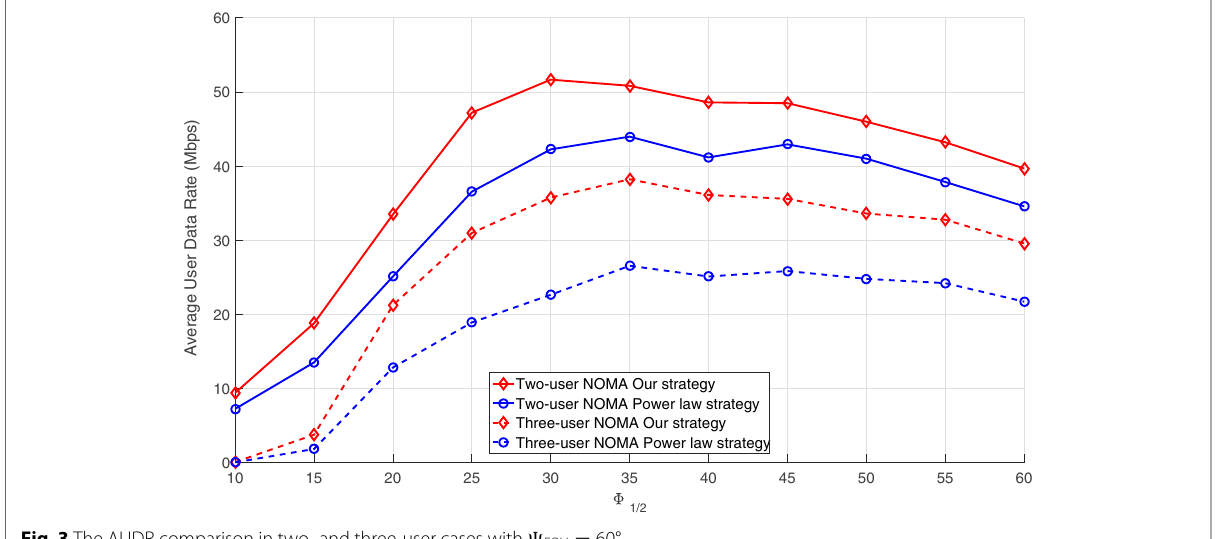
Fig. 3 The AUDR comparison in two- and three-user cases with (cid:6) FOV = 60° • Given ρ , r k , fixed (cid:6) FOV , and the definite values of power allocation factors, we focus on the relationship between (cid:5) 1 / 2 and the two-user data rate in NOMA-VLC networks, as indicated by (55). • The parameters of our alternative target forms are the same as those of the original target in Fig.